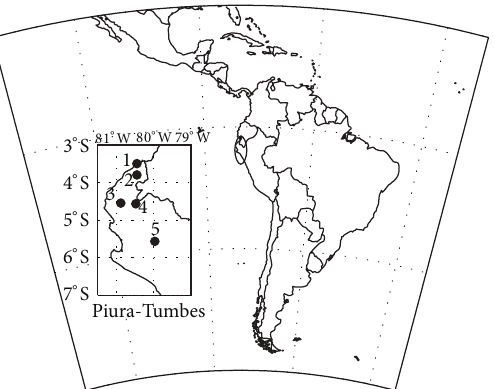
Figure 1: Location of Tumbes-Piura region and of the meteorolog- ical stations (numbers from 1 to 5).